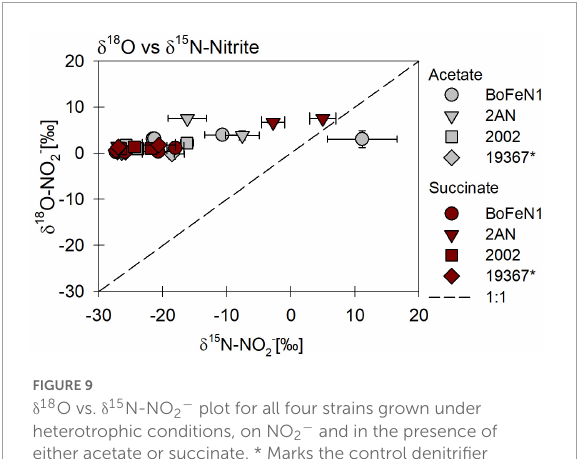
FIGURE9 − plot for all four strains grown under δ 18 O vs. δ 15 N-NO 2 heterotrophic conditions, on NO 2 − and in the presence of either acetate or succinate. * Marks the control denitrifier Paracoccus denitrificans strain ATCC